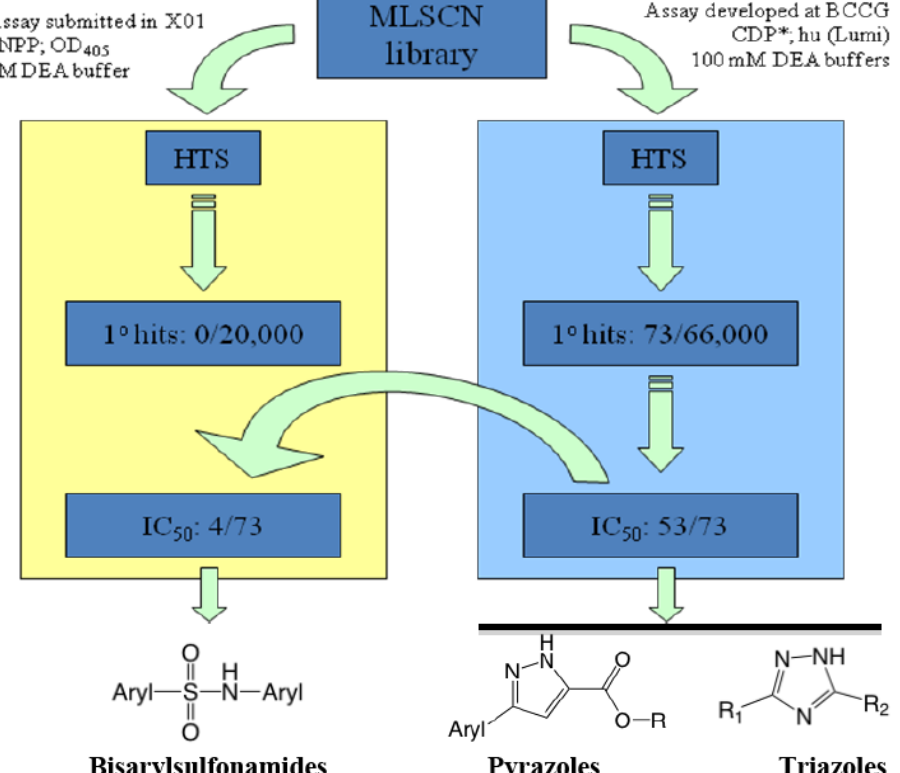
Figure 2. Comparison of the TNAP inhibitors screen in the colorimetric and luminescent